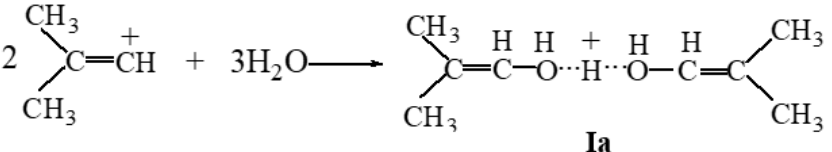
Scheme 1. Representation of the formation of cation Ia during the interaction of cation С 4 Н 7+ with water